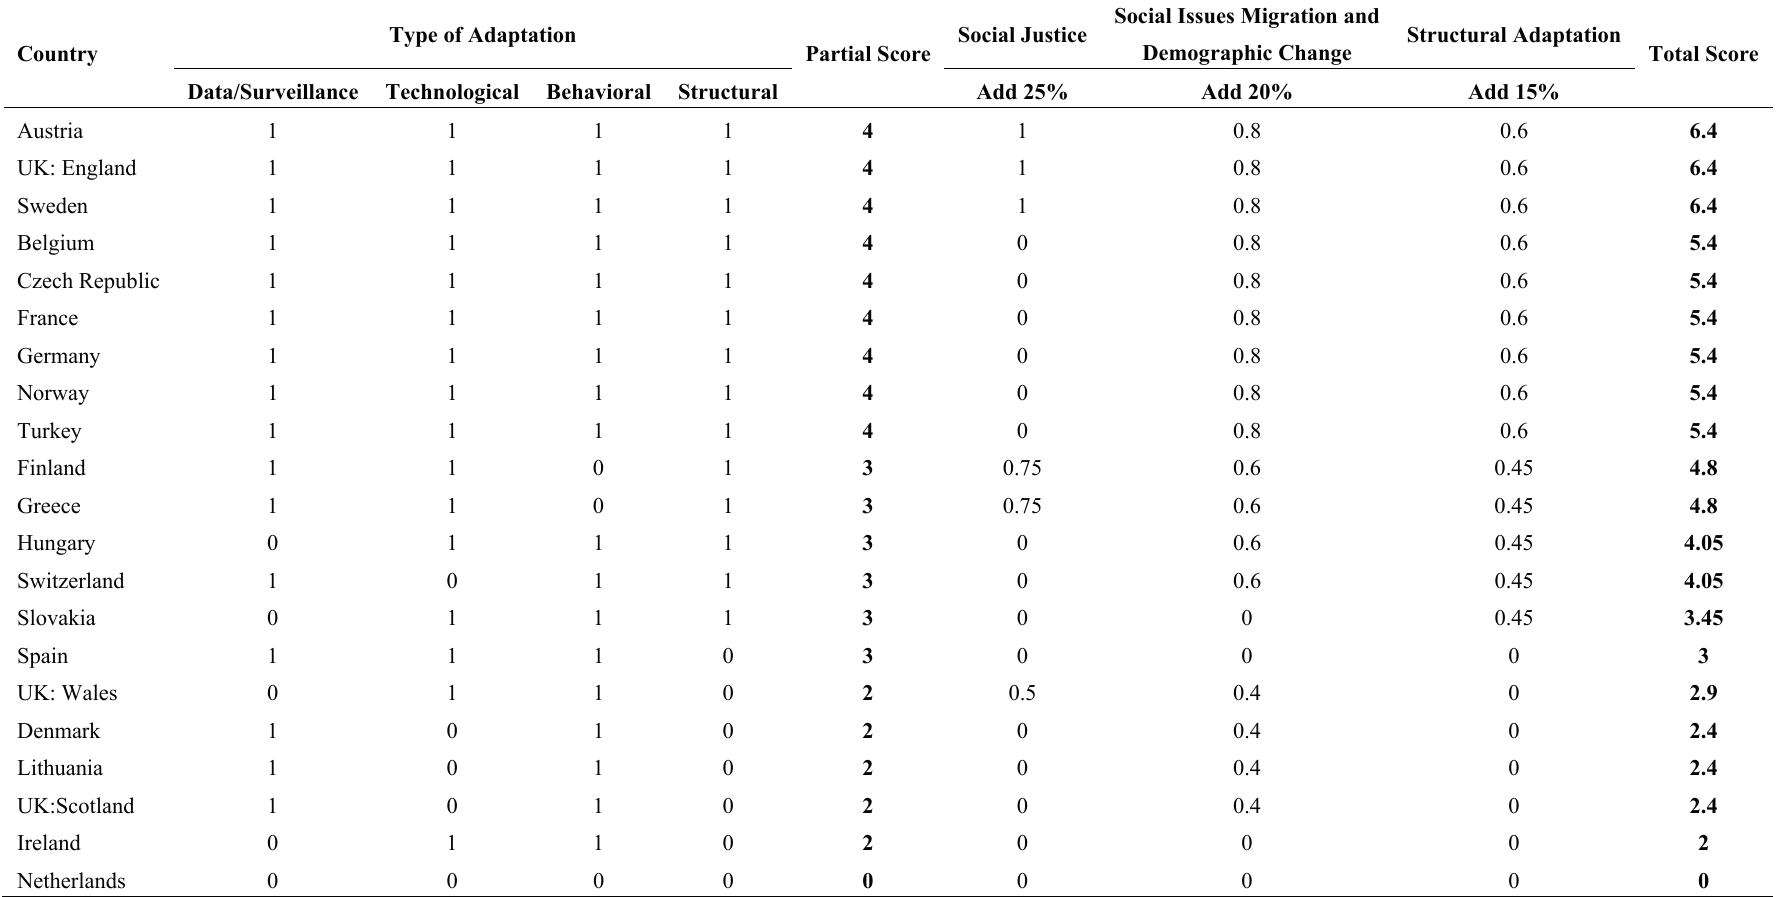
Table 1. Ranking